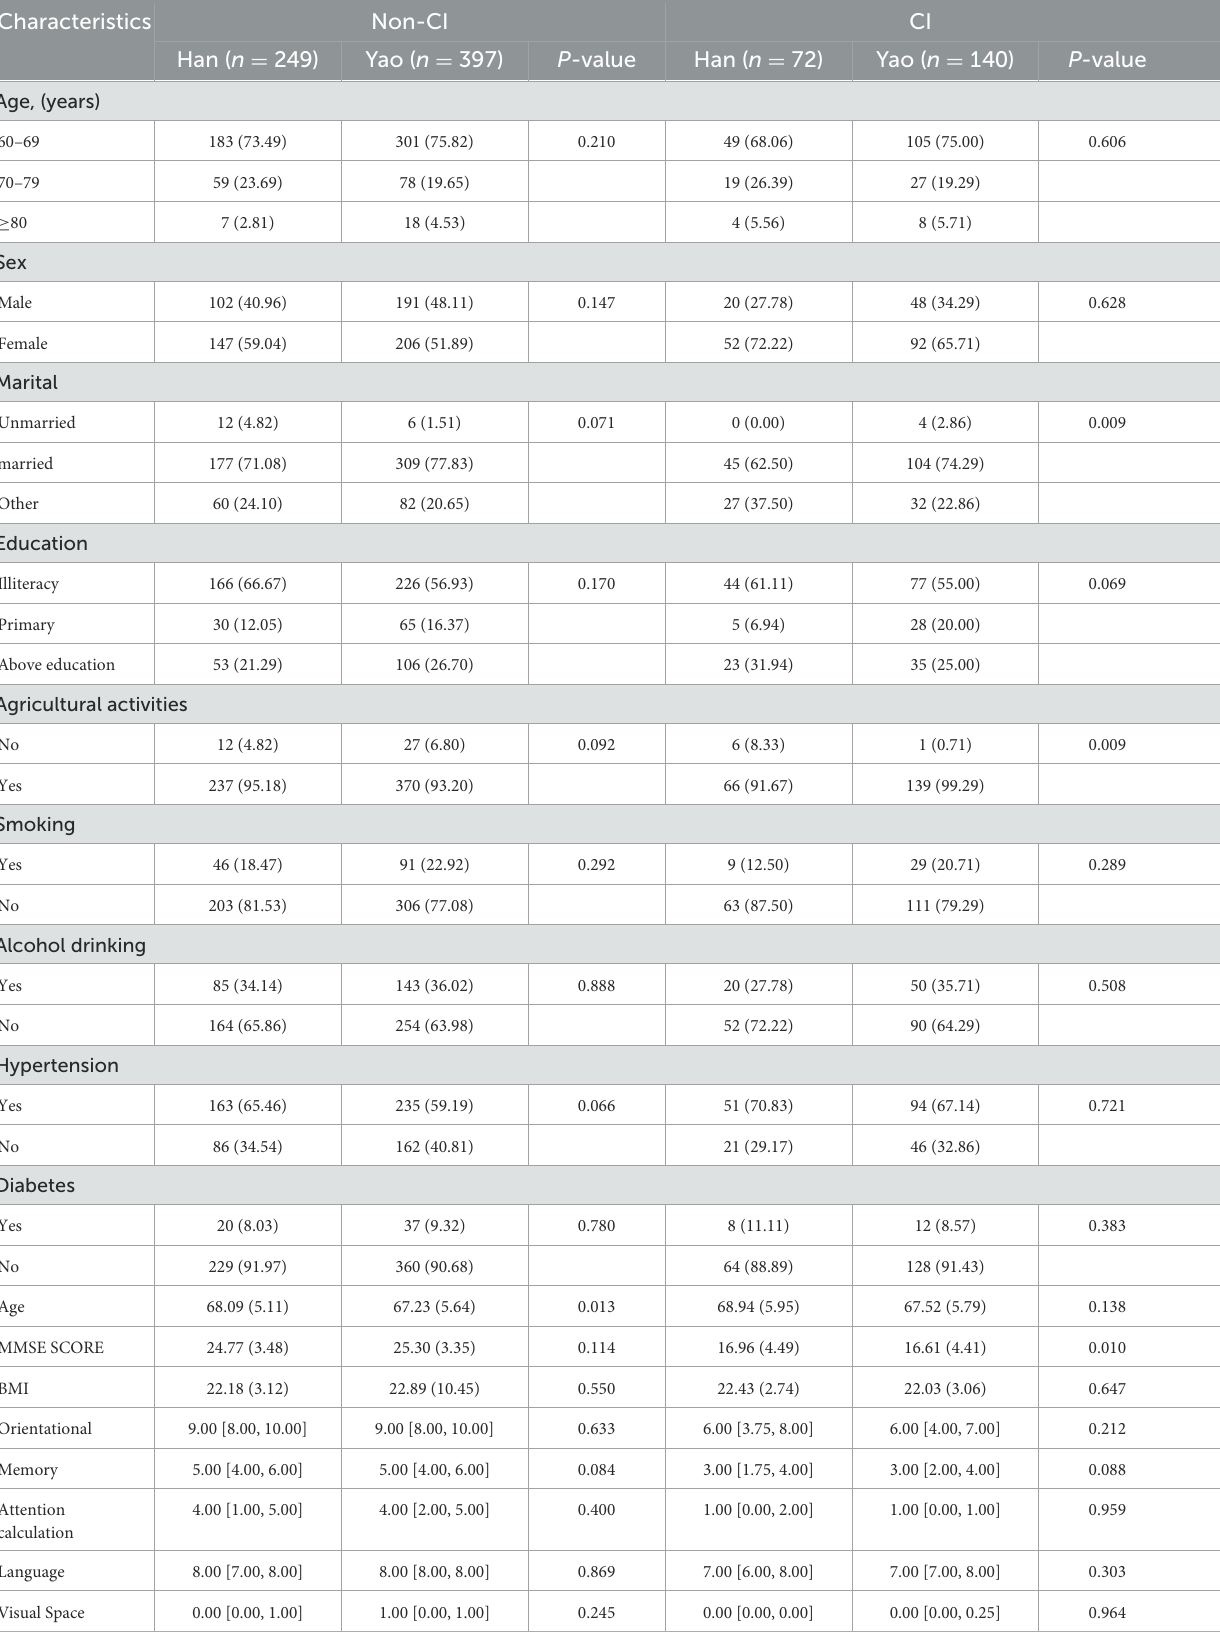
TABLE 2 Sociodemographic characteristics of